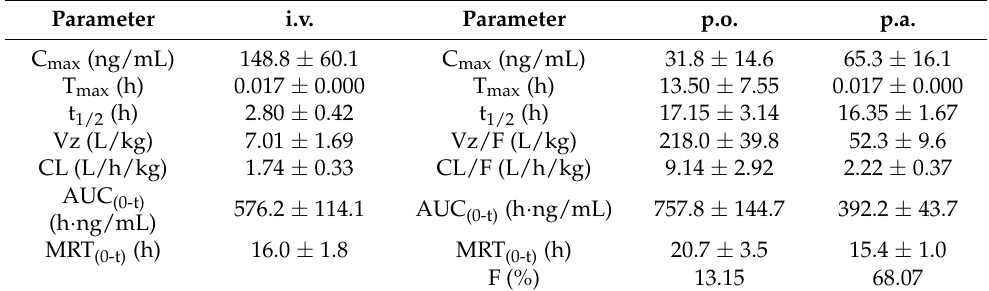
Figure 2. Mean plasma concentration-time profiles of CEP after intravenous (i.v. 1 mg/kg), oral (p.o. 10 mg/kg), and pulmonary administration (p.a. 1 mg/kg) ( n = 4). Table 3. Pharmacokinetic parameters of CEP after intravenous (i.v., 1 mg/kg), oral (p.o., 10